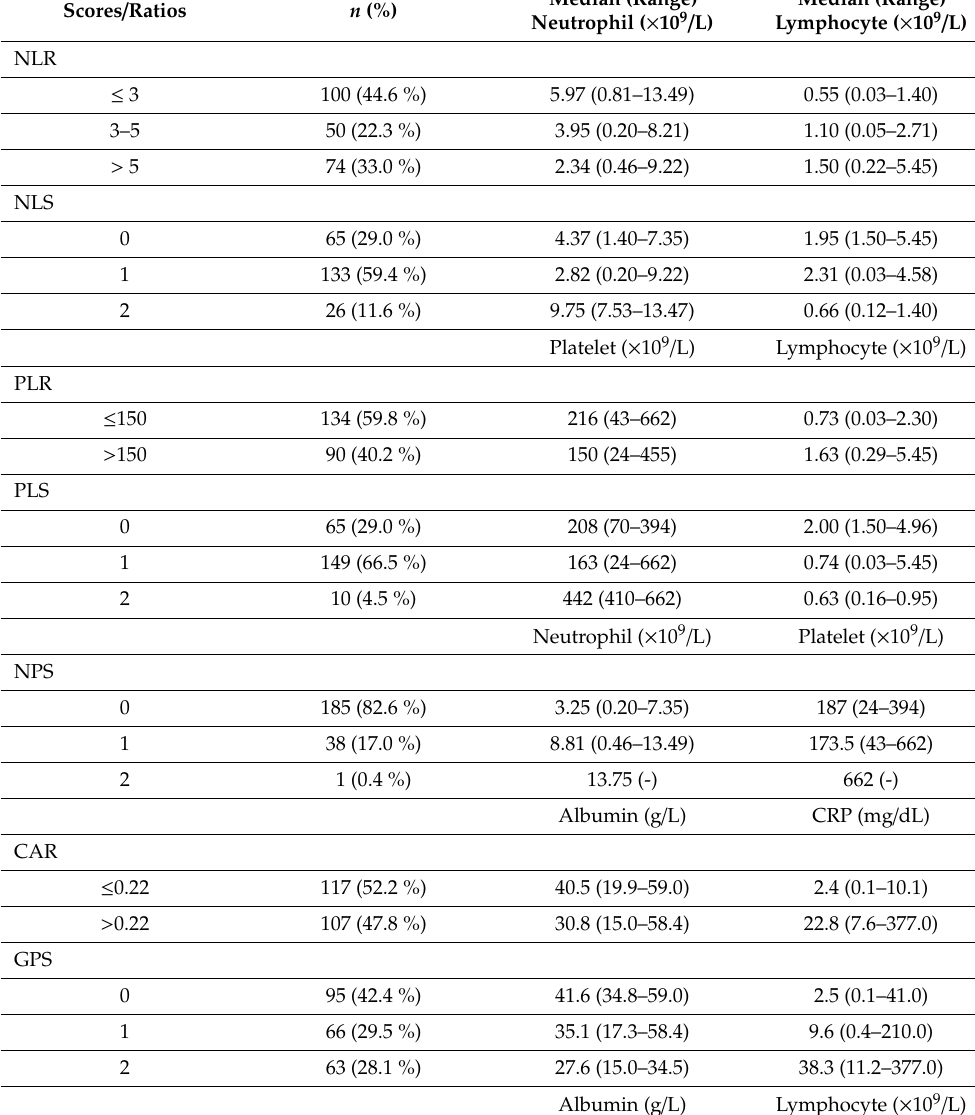
Table 3. The relationship between composite ratios and cumulative scores and their component values in autologous stem cell transplanted (ASCT) patients with multiple myeloma (MM) ( n =